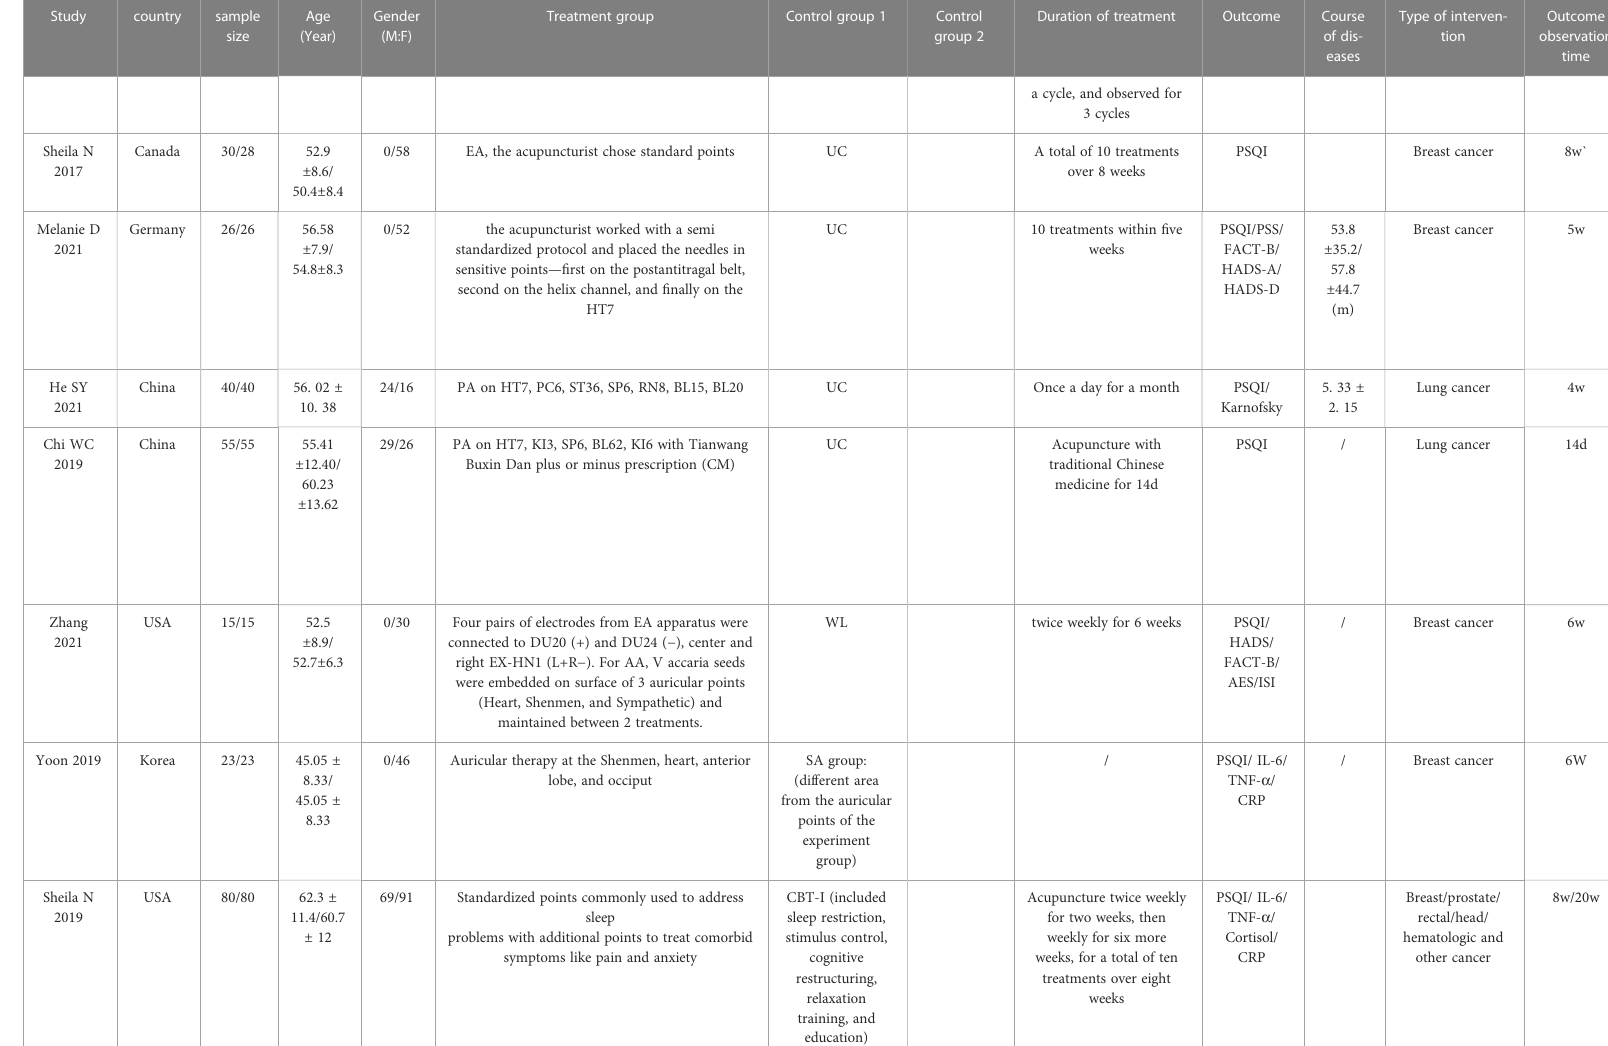
CBT-I (included sleep